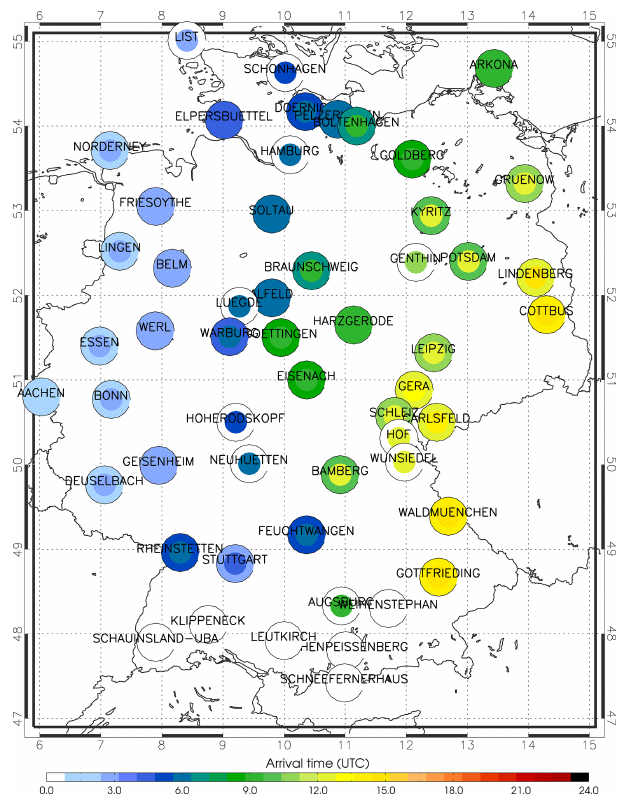
Figure 8. Arrival time of individual SD plume on 16 October 2017, color coded by the hour of day, as measured by ceilometer (outer ring) and IFS-AER (inner bullet). Missing data are in white: the selected plume did not reach the southernmost part of Germany or arrival could not be identified due to low